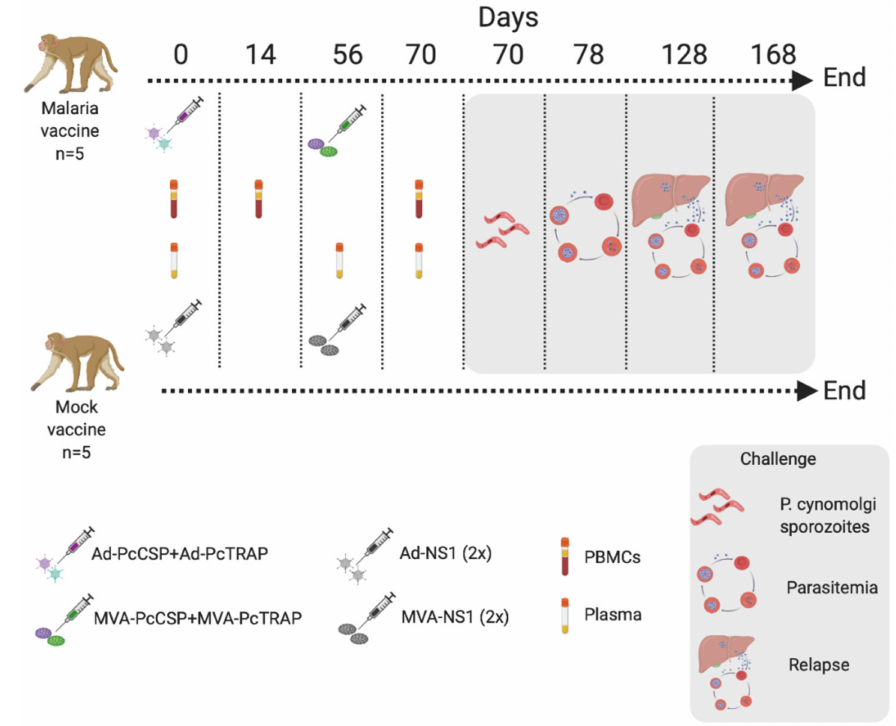
Figure 4. Description of Nonhuman Primates (NHP) challenge experiment. Created with